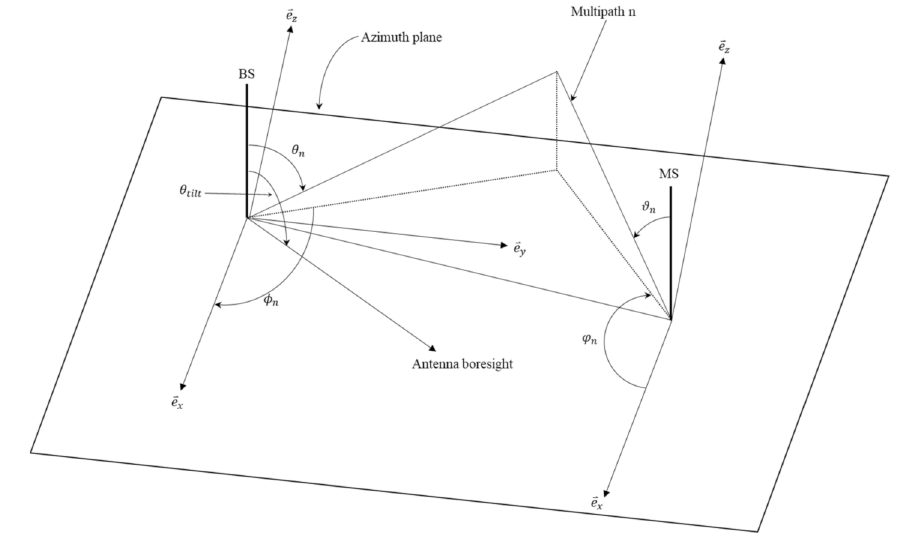
Figure 1. Schematic diagram of a 3D channel